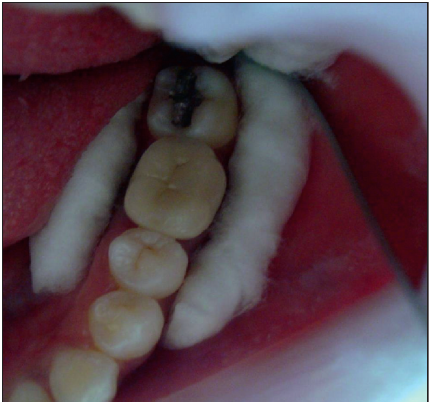
Figure 10: Occlusal view following final cementation.